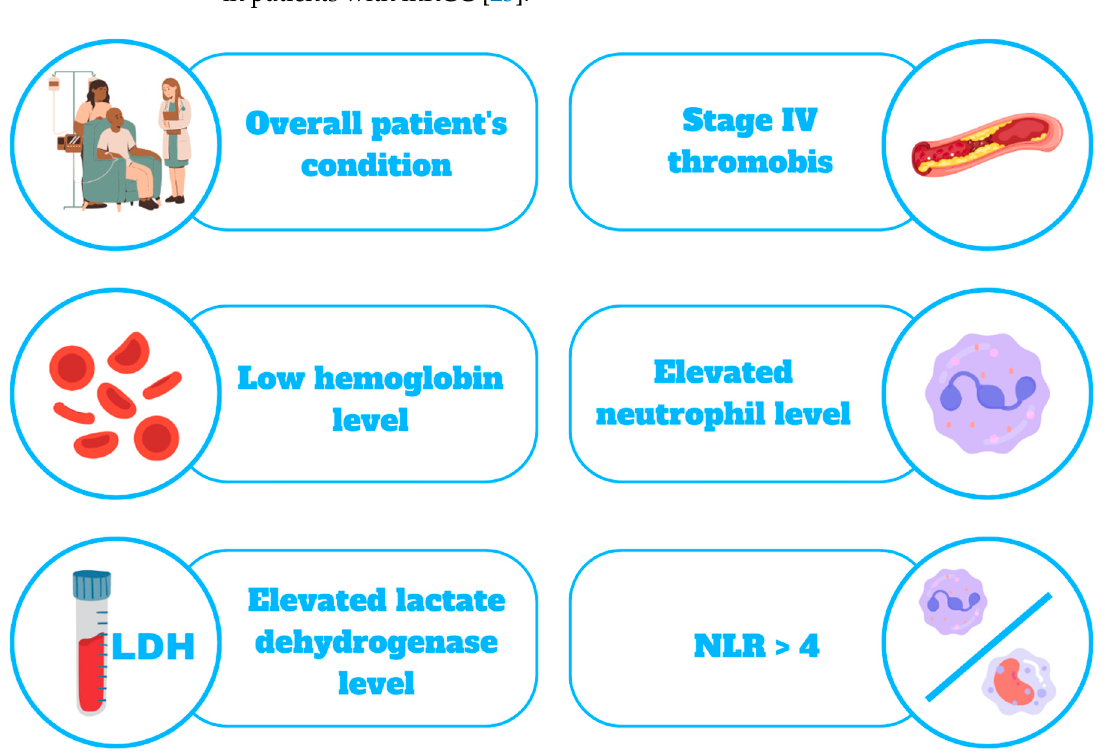
Figure 2. Selected prognostic factors of RCC. NLR—neutrophil to lymphocyte ratio, LDH—lactate dehy- drogenase.